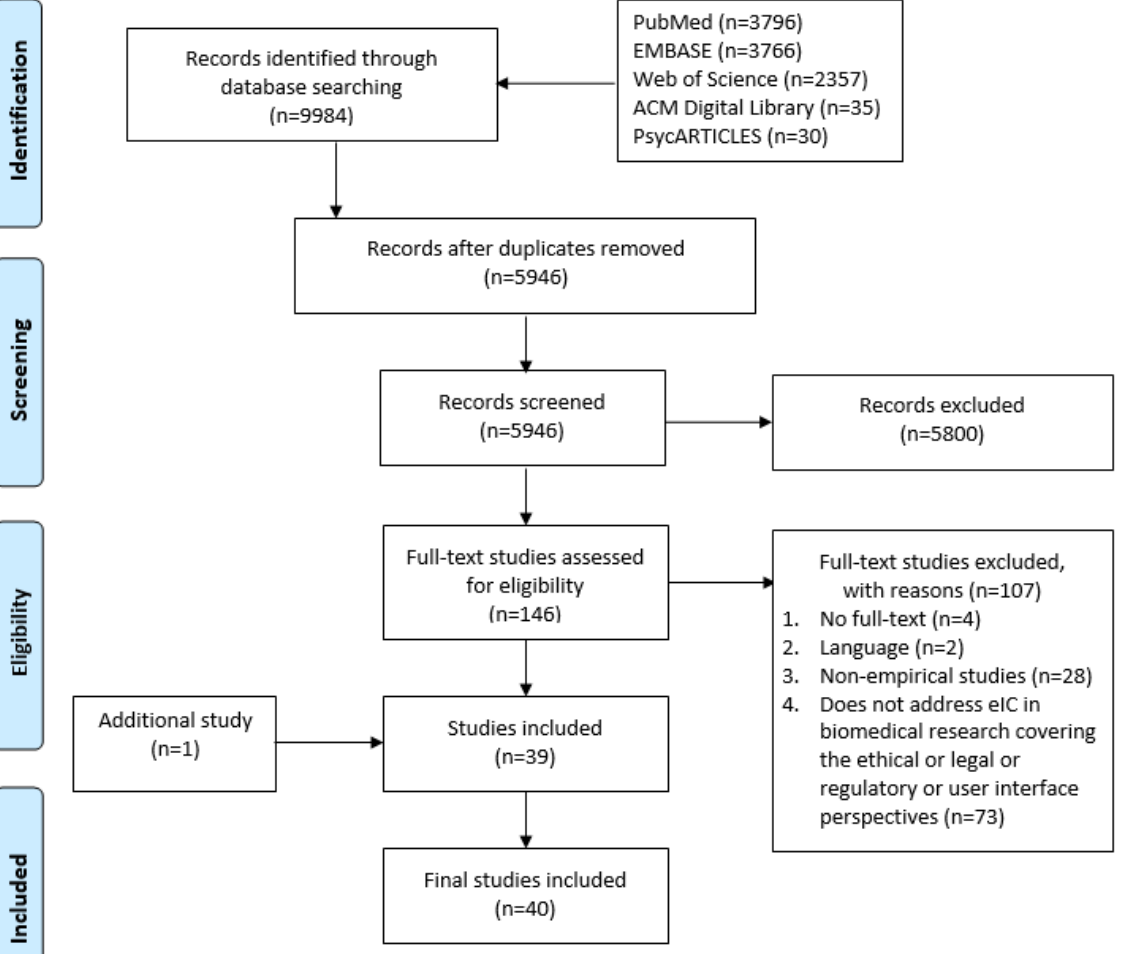
Figure 1. PRISMA flowchart of the systematic review. eIC: electronic informed